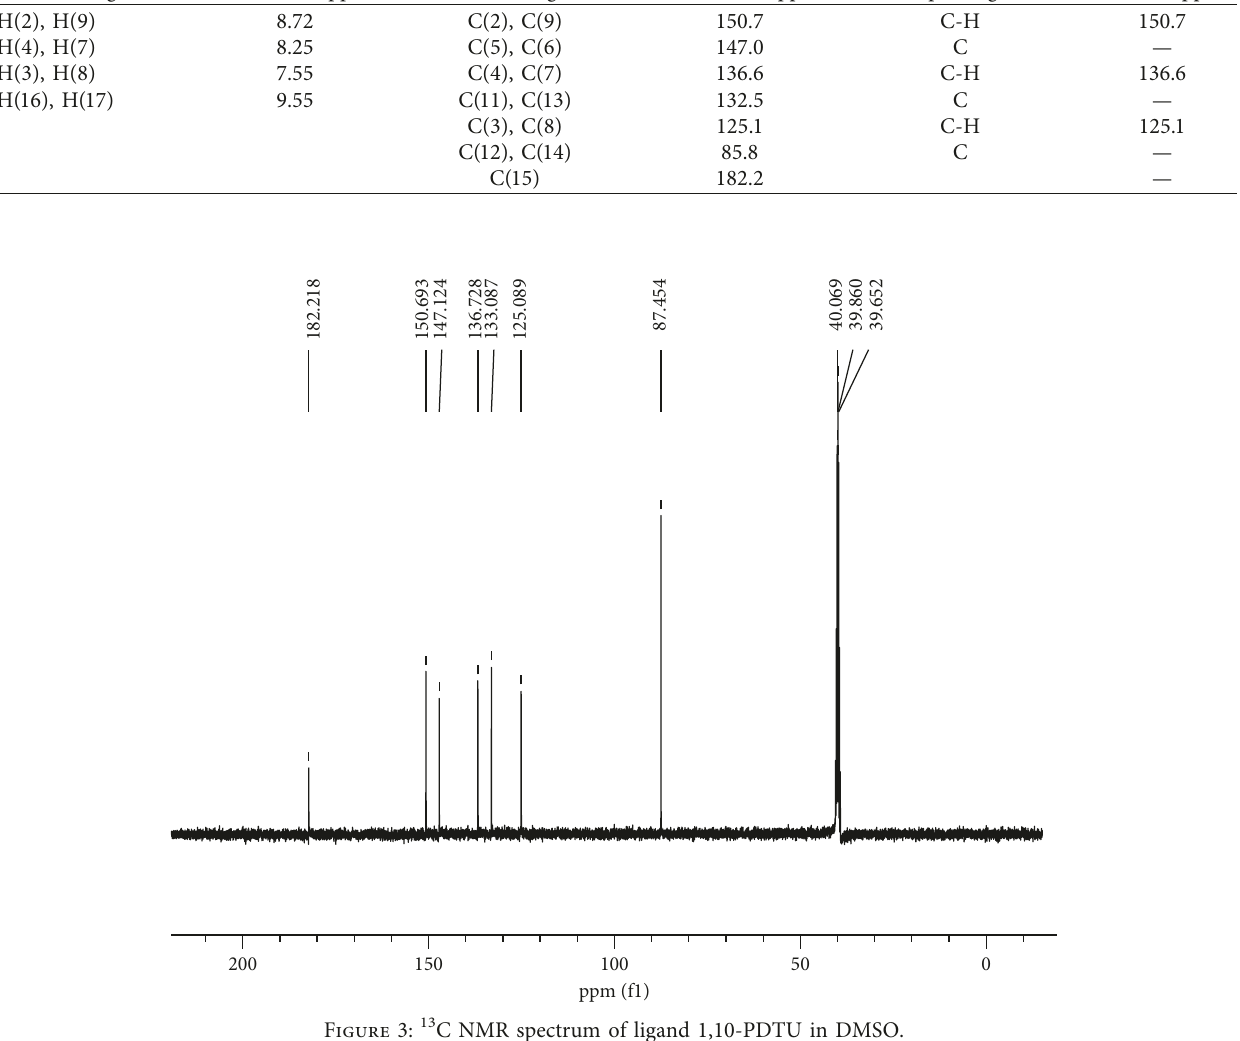
Table 2: 1 H-NMR, 13 C NMR, and DEPT 135 of the ligand as depicted in Figure 1. Proton (assigned)